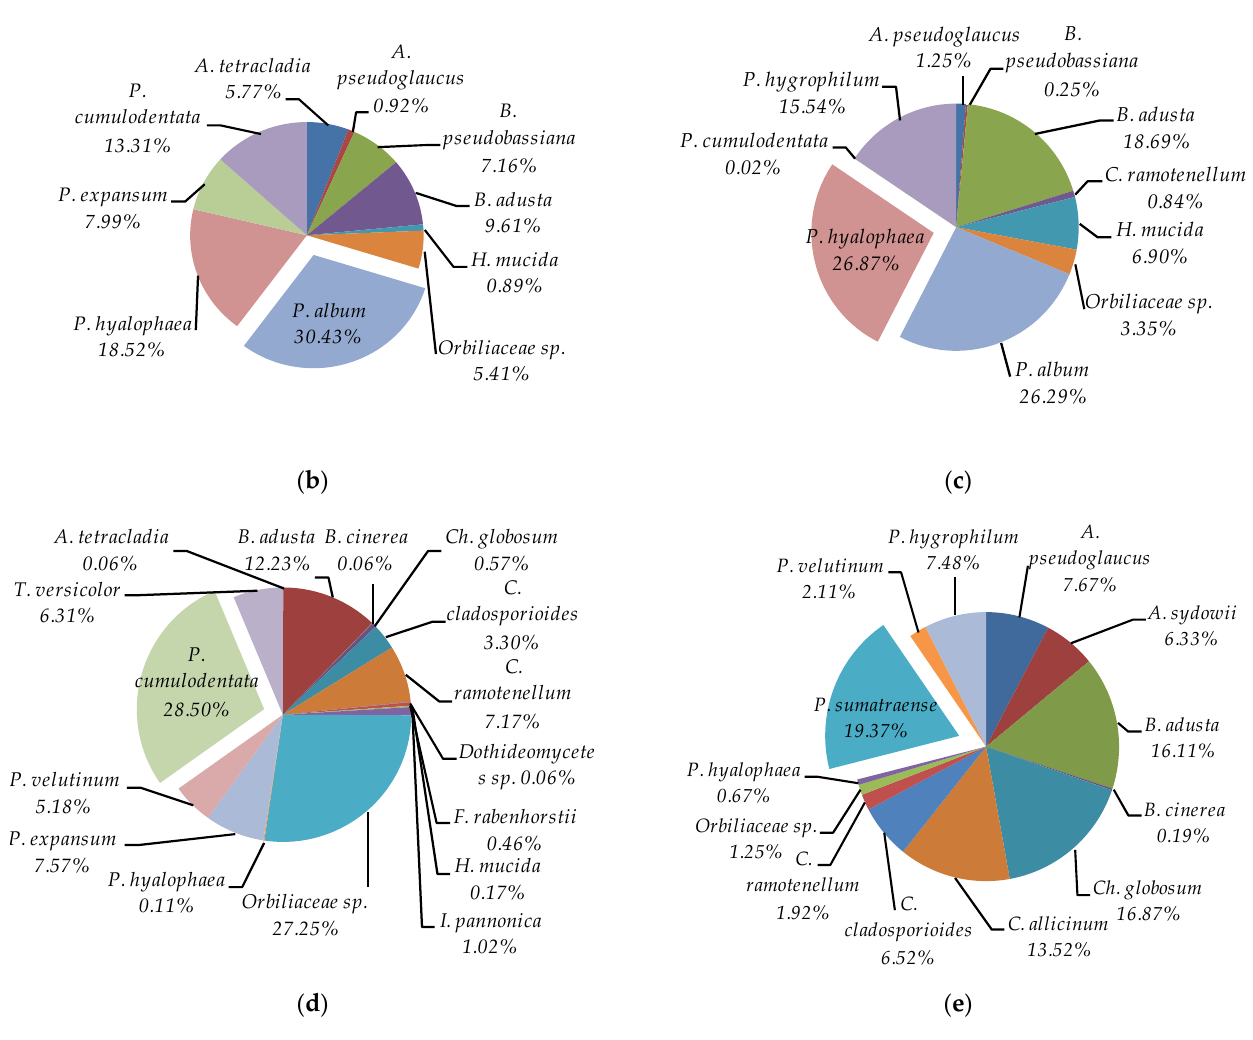
Figure 3. Percentage of each fungus contributing to the total fungi cultured from the cryoconite holes in the Werenskiold Glacier (Spitsbergen) using different culture media and different incubation temperatures: ( a ) overall for all incubation temperatures and for all culture media, ( b ) on PDA incubated at 7 ◦ C, ( c ) on YPG incubated at 7 ◦ C, ( d ) on PDA incubated at 24 ◦ C, and ( e ) on YPG incubated at 24 ◦